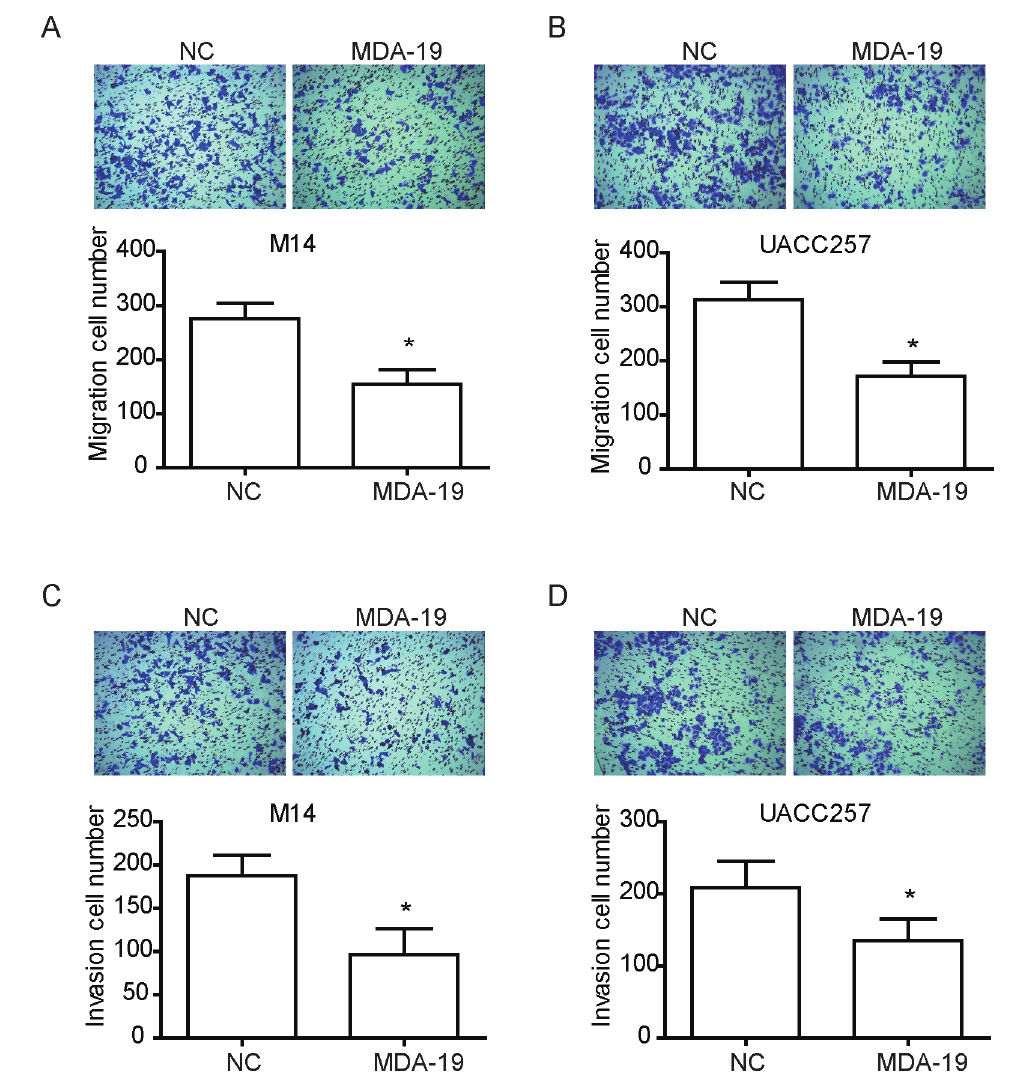
Figure 3: MDA-19 attenuates migration and invasion of melanoma cells in vitro. M14 cells was treated with 20 μM of MDA-19, and UACC257 cells was treated with 10 μM of MDA-19. (A) (B) After treatment with MDA-19 for 24h, Transwell assay was performed to examine cell migra- tion capability in M14 cell (A) and UACC257 cell (B). (C) (D) After treatment with MDA-19 for 24h, Transwell assay was performed to examine cell invasion capability in M14 cell (C) and UACC257 cell (D). Data are expressed as the mean ± SD. MDA-19: MDA-19 treated group; NC: DMSO treated group, negative control.